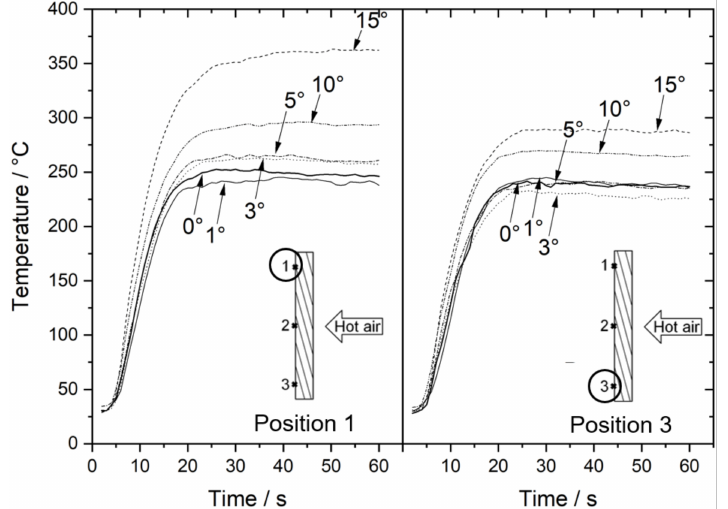
Figure 8. Temperature profiles on the back side of samples with different fibre angles during hot-air treatment: measured at position 1 (left); measured at position 3